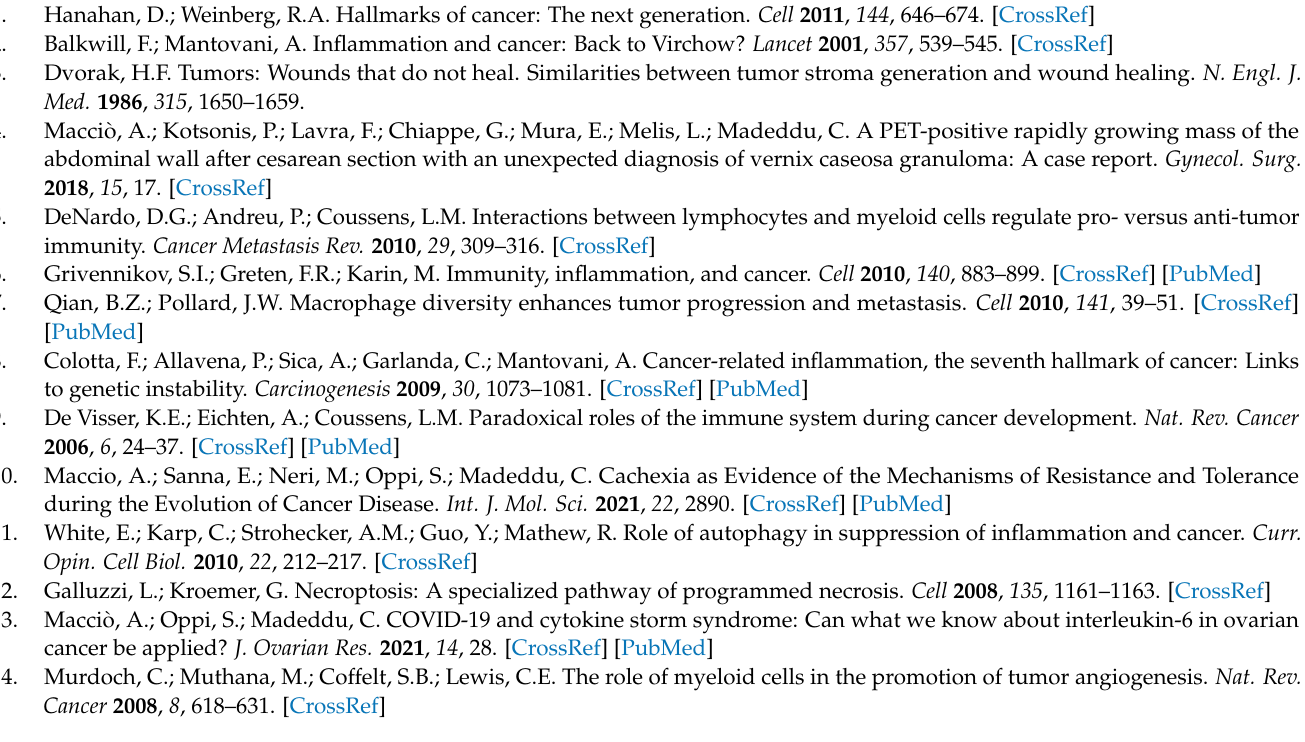
Figure S3: Intratumoral lympho-monocytic and granulocytic infiltrate; Figure S4: HIC intratumoral and peritumoral staining of IL-6 and